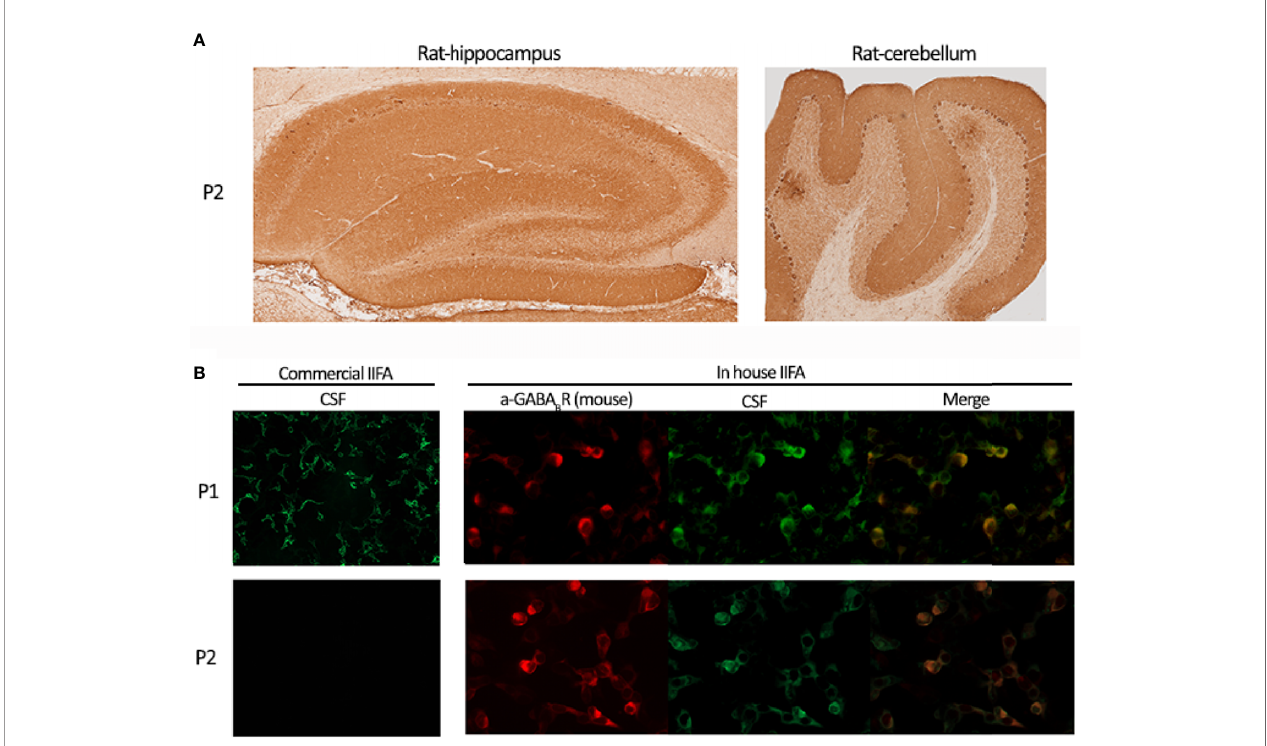
FIGURE 2 | Discrepancies identifying GABA B R antibodies by IIFA. (A) One of the two patients ’ CSF (P2) demonstrating GABA B R immunoreactivity on rat brain immunohistochemistry. Hippocampus (left panel) and cerebellum (right panel) staining patterns. (B) Upper panels show patient 1 ’ s CSF (P1) reactivity on commercial IIFA and in-house IIFA GABA B R transfected cells; lower panels show patient 2 ’ s CSF (P2) reactivity on commercial IIFA (negative staining) and in-house IIFA (positive staining) GABAbR transfected